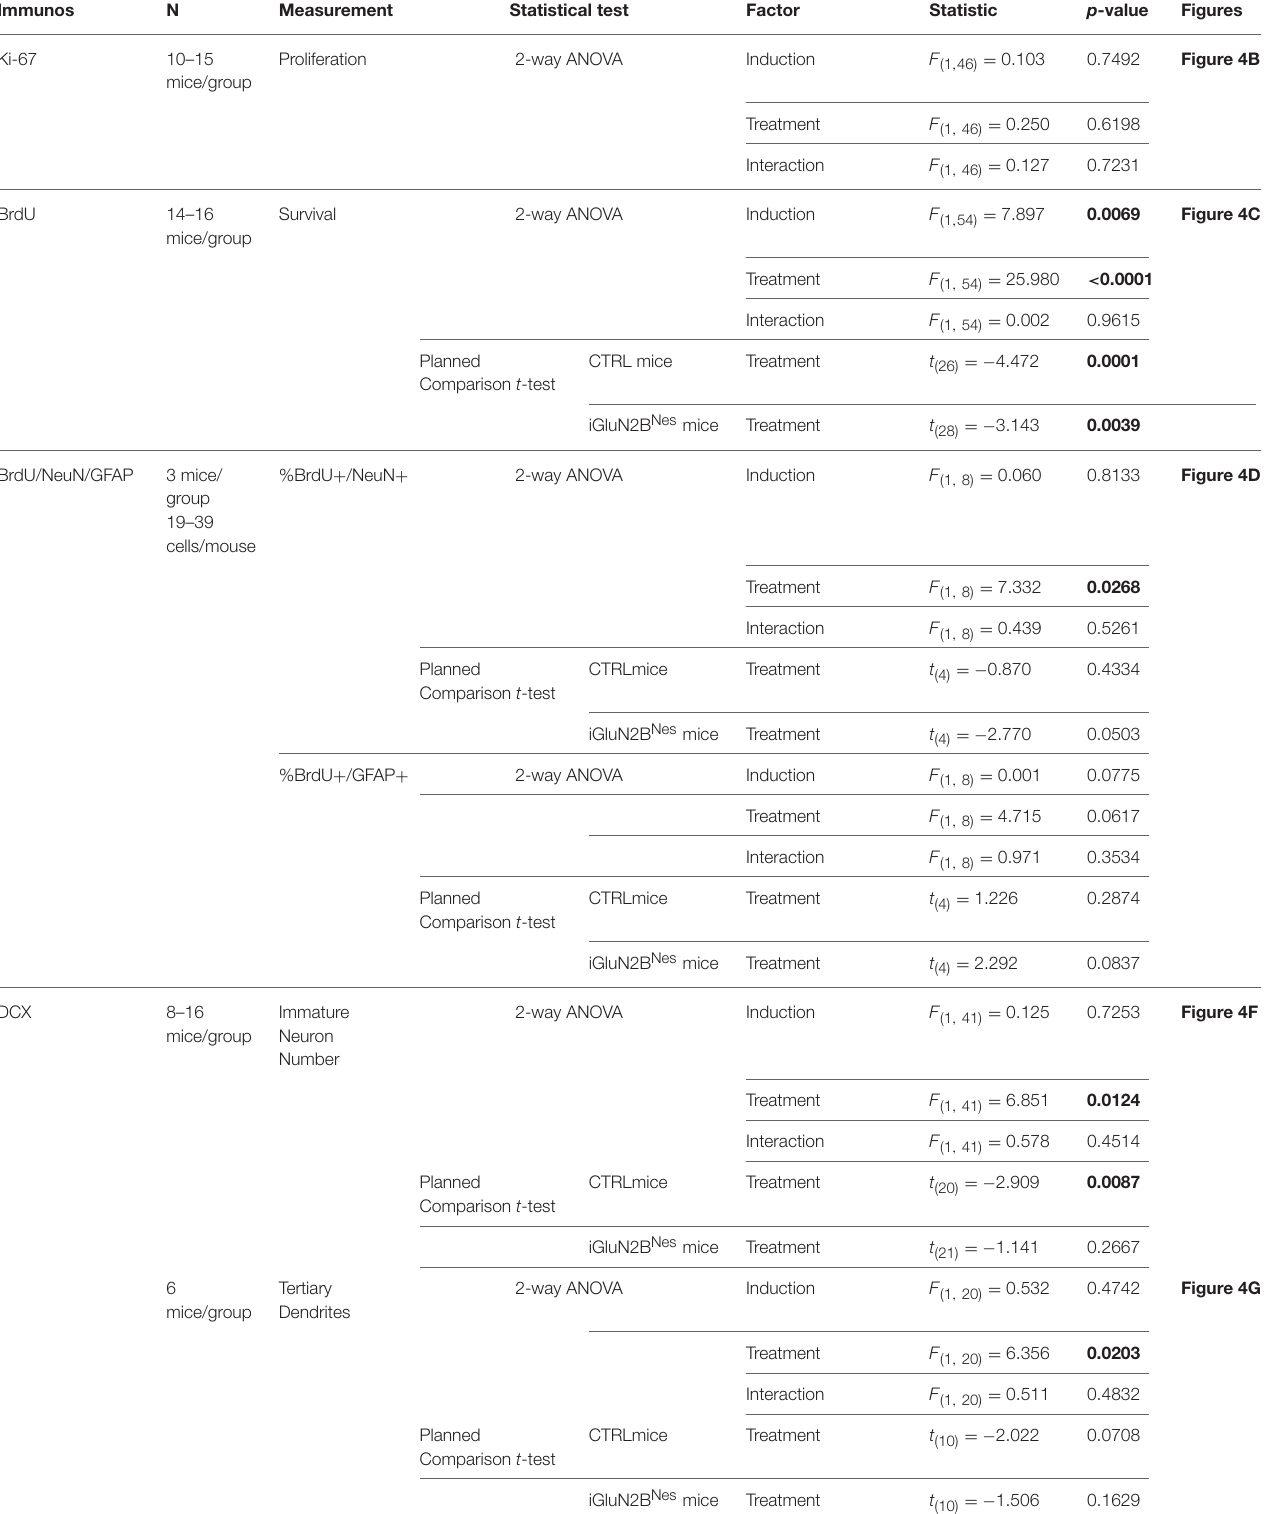
TABLE 2 | Statistical analysis of neurogenesis